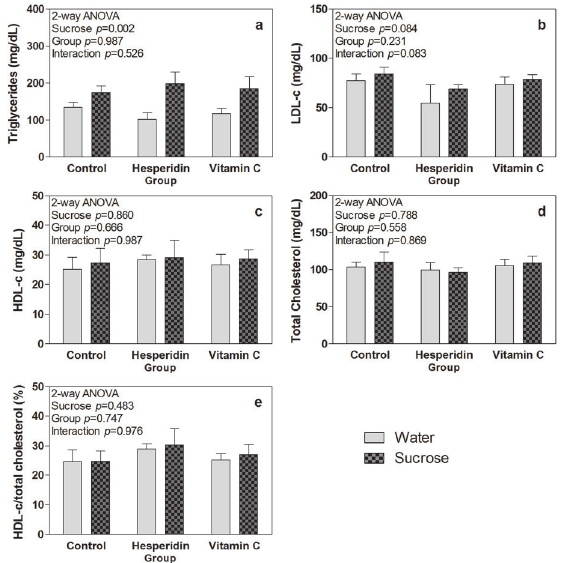
Figure 2 - Influence of vitamin C and hesperidin on triglycerides ( a ), low density lipoprotein cholesterol ( b ), high density lipoprotein cholesterol ( c ), total cholesterol ( d ), and high density lipoprotein cholesterol/total cholesterol ( e ) in rats treated with sucrose. Resuts of two-way ANOVA